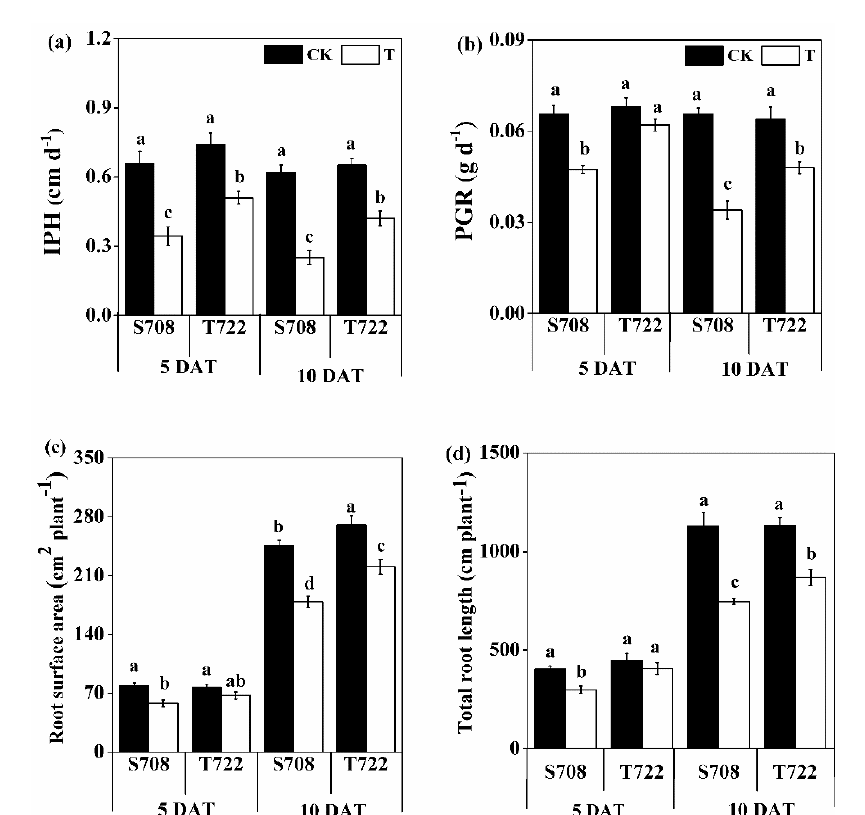
Figure 1. Phenotypic response of the two tomato cultivars to sub-optimal temperature. ( a ) Increase in plant height (IPH), ( b ) plant growth rate (PGR), ( c ) root surface area, and ( d ) total root length of S708 and T722 cultivars grown at normal temperature (CK, 25 / 18 ◦ C) and sub-optimal temperature (T, 15 / 10 ◦ C) at 5 and 10 DAT. Data are the means with standard deviation shown by vertical bars (n = 3 representing 3 biological replicates). The di ff erent small letters above the bars represent significant di ff erences attested by the Tukey’s HSD test ( p < 0.05).